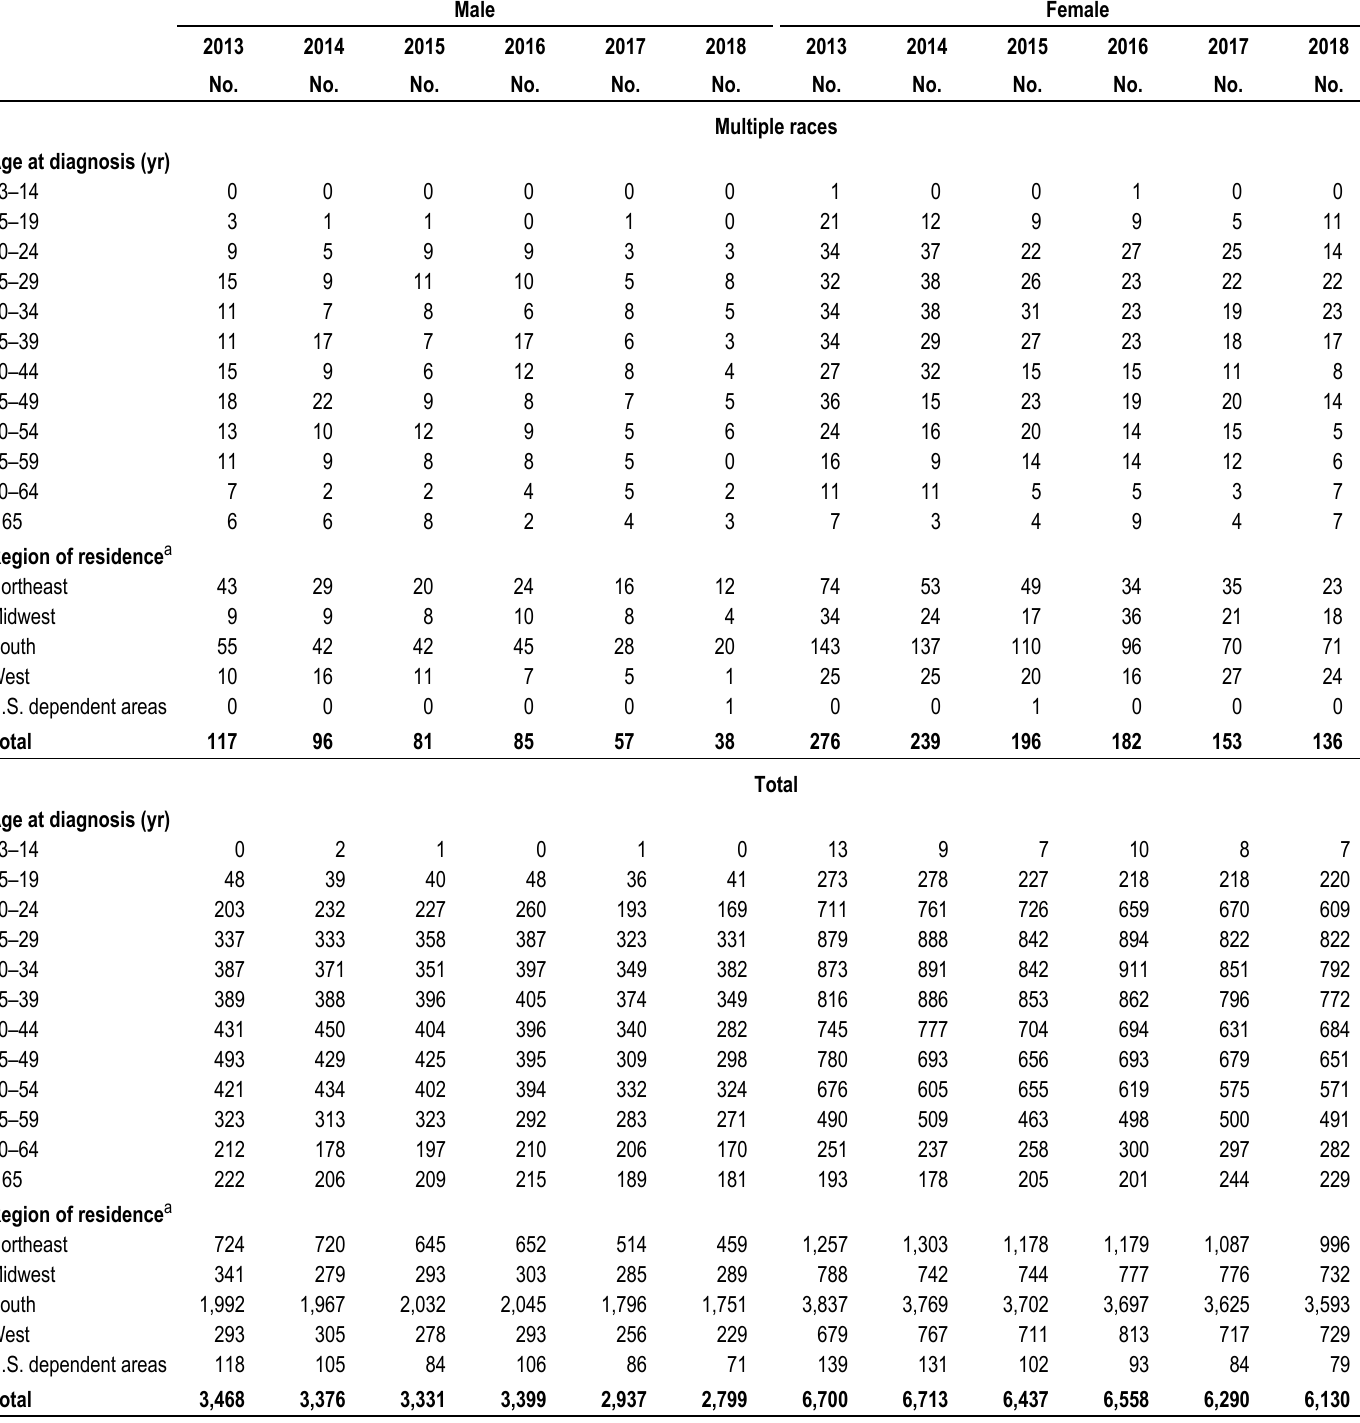
Table 9b. Diagnoses of HIV infection attributed to heterosexual contact, by selected characteristics, 2013–2018—United States and 6 dependent areas